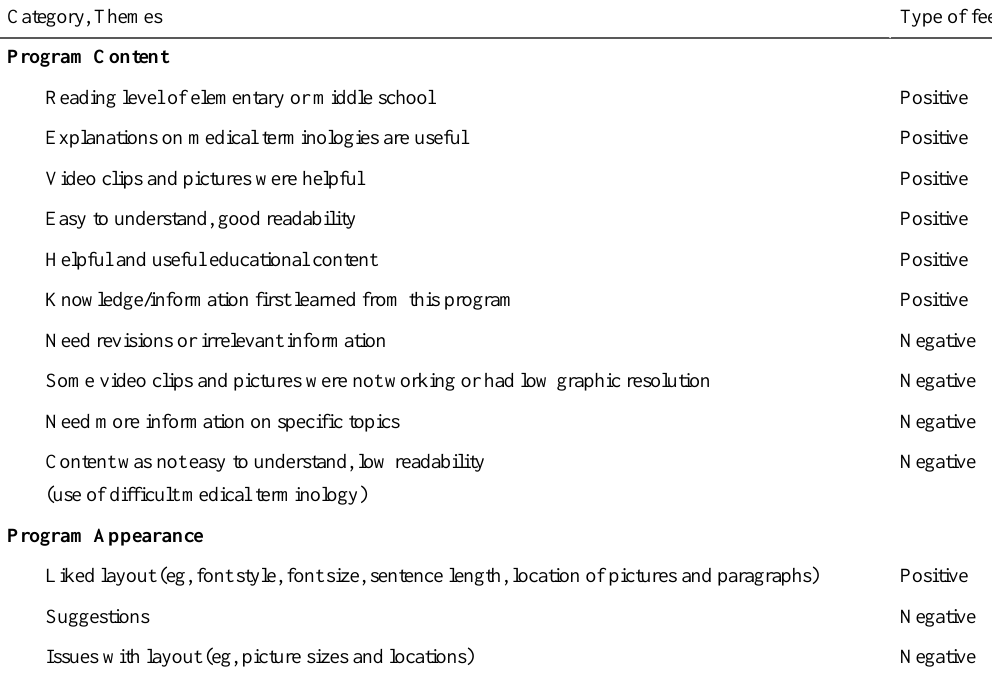
Table 5. Content analysis of user testing transcriptions